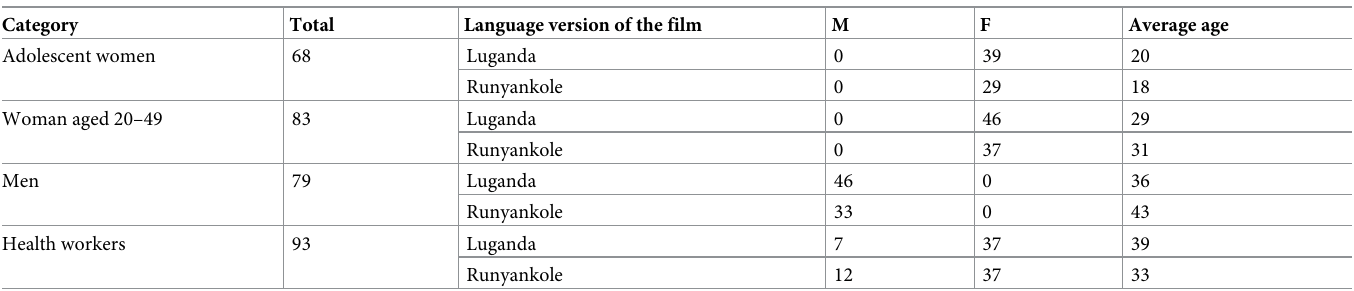
Table 2. Characteristics of focus group